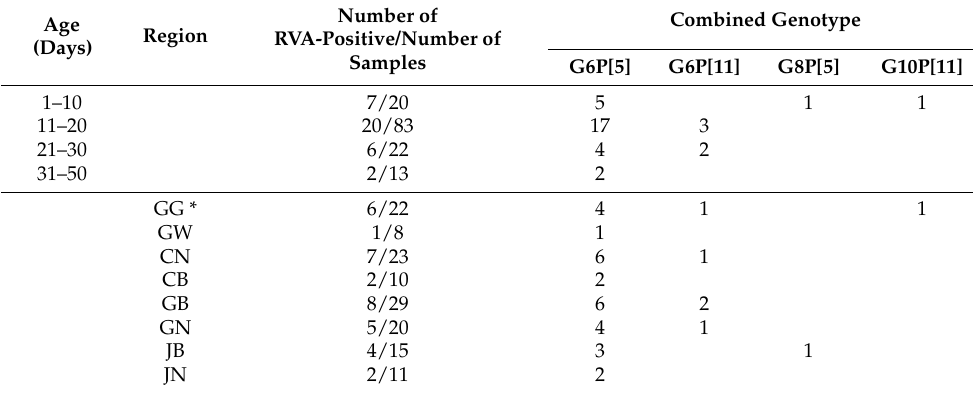
Table 3. Prevalence of combined genotypes (according to age and region) in 35 BoRVA-positive Korean calves sampled between 2014 and